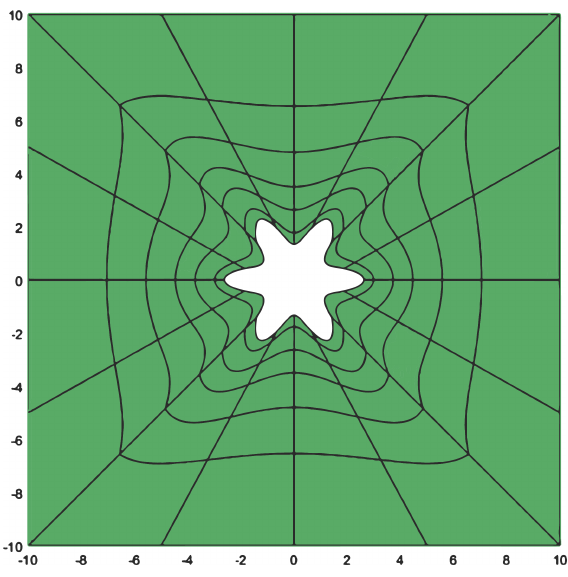
Figure 20. Case 4: physical domain and mesh with h 2 -refinement.